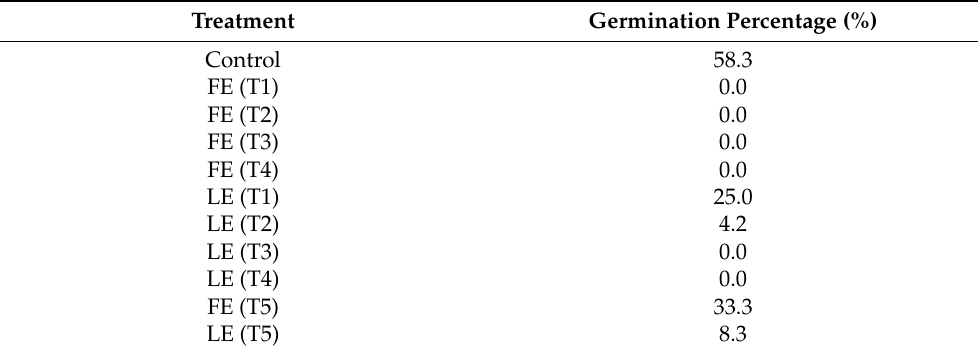
Table 4. Germination percentage after 10 days of rocket seeds treated with water (control = C) and with borage extracts (flowers extract = FE or leaves extract = LE) obtained with different maceration times: 1 day (T1), 3 days (T2), 7 days (T3), and 14 days (T4) and compared with FE and LE obtained after 25 days of maceration